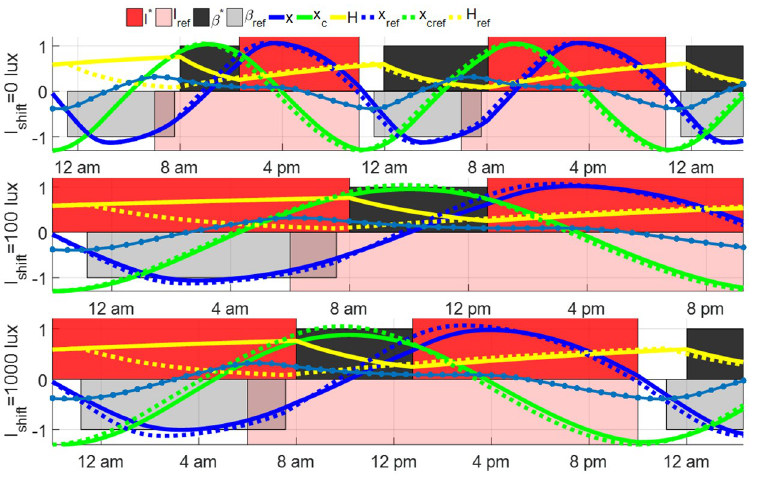
Fig 15. Open-loop entrainment with different lighting condition I shift during night shift between 10 pm to 8 am, where the open-loop entrainment time is 44.06 hours for I shift = 0 lux, 13.25 hours for I shift = 100 lux and 18.32 hours for I shift = 1000